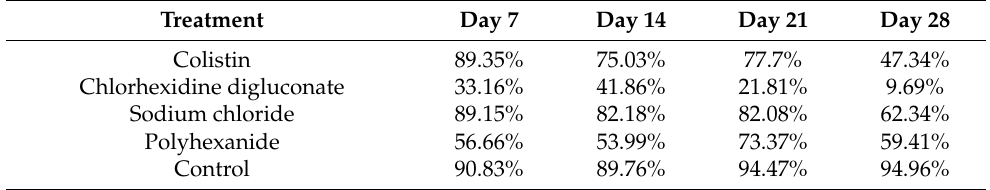
Table 1. Cell viability percentage media for each treatment and control at days 7, 14, 21, and 28; n =